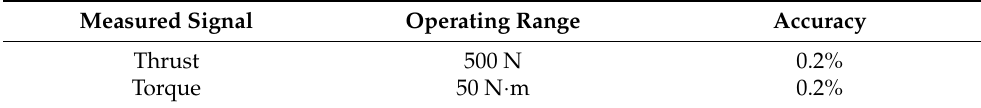
Table 3. Measuring range and accuracy of turbine